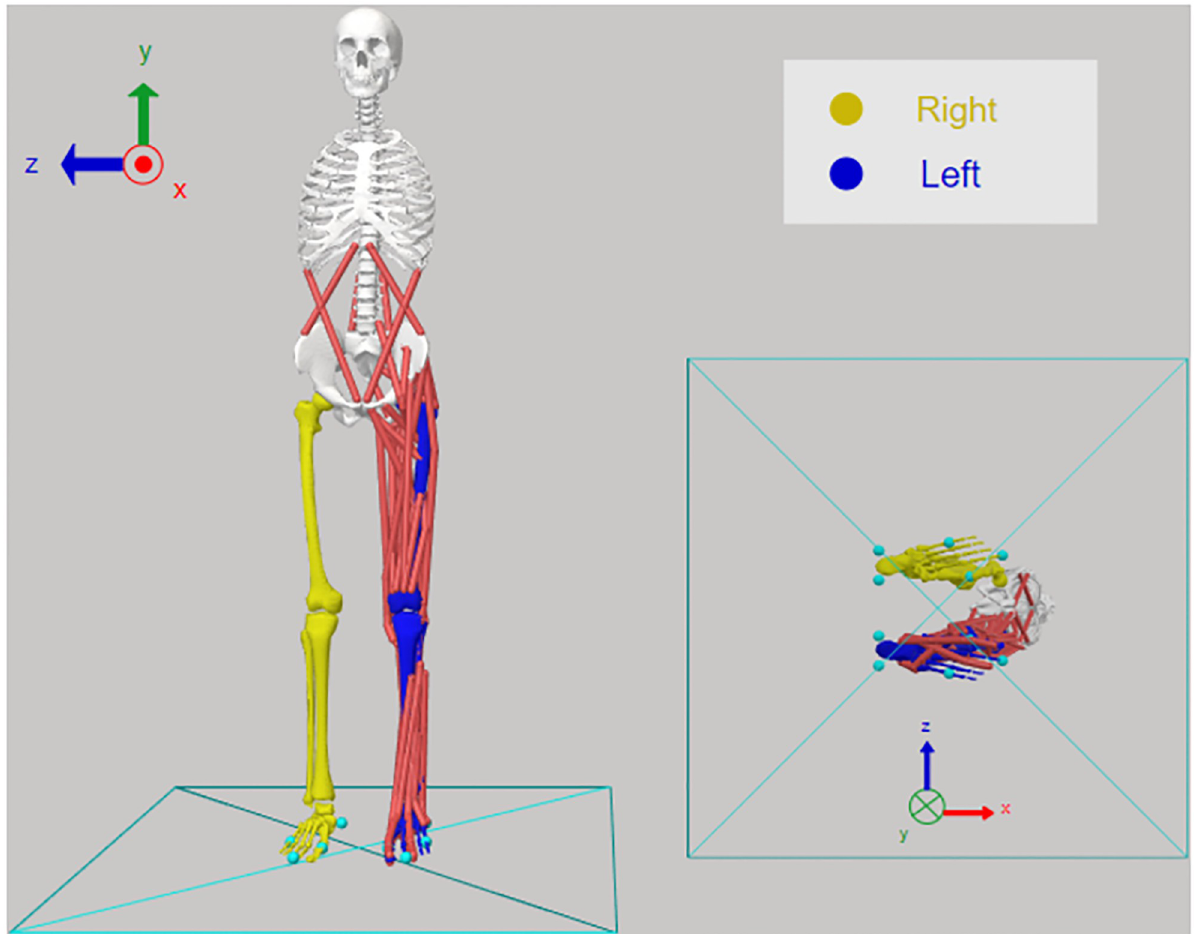
Fig 4. Schematic diagram of the “Gait2392” musculoskeletal model. Schematic diagram of the “Gait2392” model with only the left side muscles. Foot-ground contact was modeled with five contact spheres per foot.